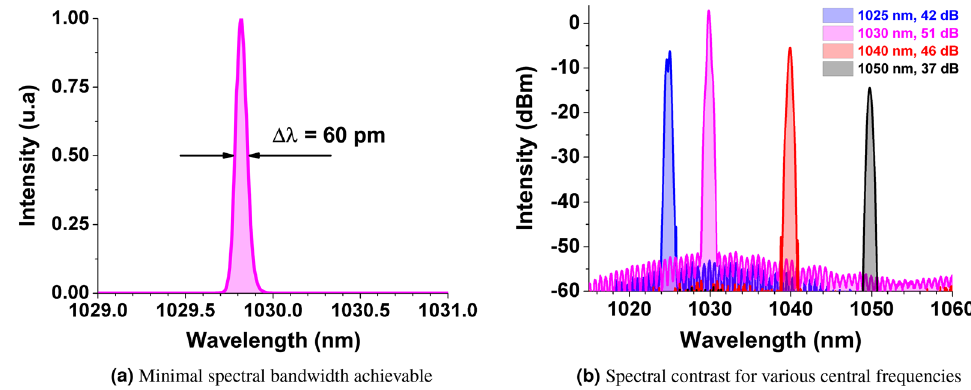
Figure 4. Narrow band configuration of the CW ASE seeder.